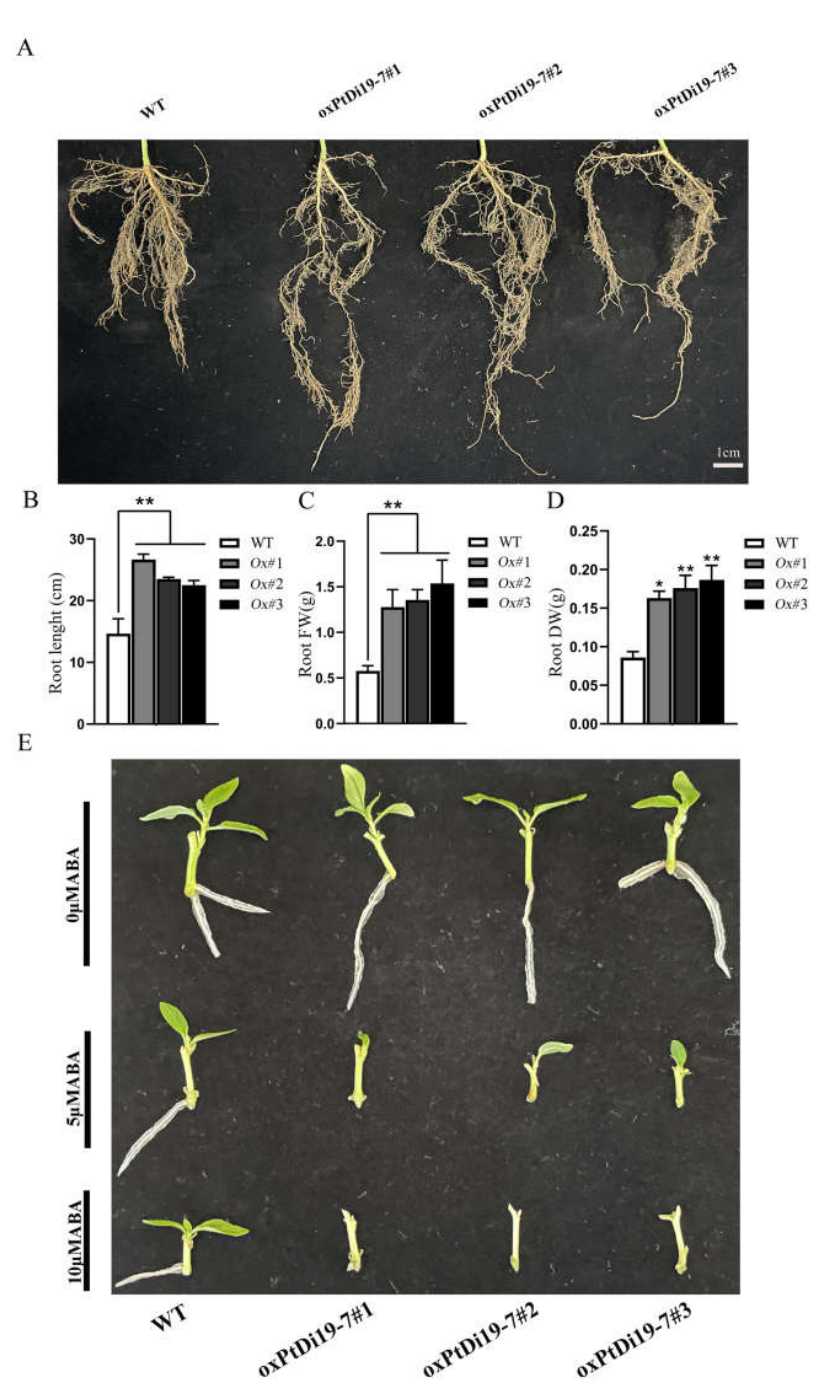
Figure 10. PtDi19–7 affects root development of transgenic poplar and responds to exogenous ABA. ( A ) Phenotypic analysis of root length after 8 days of drought treatment. ( B ) The root length measurement. ( C ) The root fresh weight. ( D ) The root dry weight. ( E ) Lateral bud outgrowth of short shoot segments grown for 3 weeks on 1/2 MS medium supplemented with ABA (5/10 µ M) or without ABA of WT and oxPtDi19–7 plants. A p -value of <0.05 was considered to be significant (*), and a p -value of <0.01 was considered to be extremely significant (**).